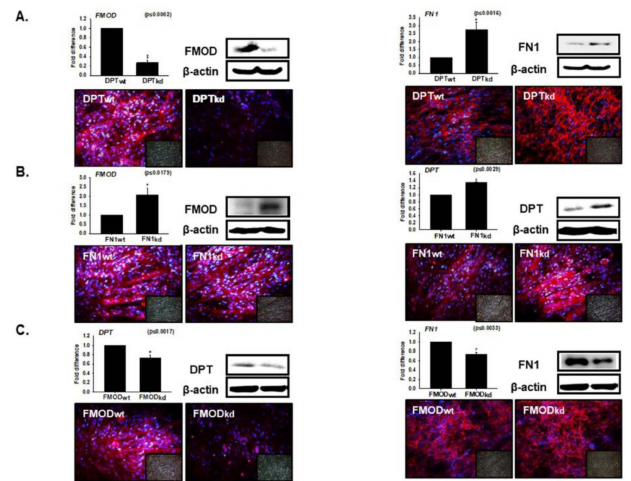
Figure 4. Relationship of DPT with fibromodulin (FMOD) and FN during myoblast di ff erentiation. Knockdown cells of FMOD, DPT, and FN were incubated with 2% FBS for 4 days. ( A ) FMOD and FN mRNA expression were evaluated by real-time RT-PCR, and protein expression by Western blot and immunocytochemistry in DPT kd cells. ( B ) FMOD and DPT mRNA expression was assessed by real-time RT-PCR, and protein expression by Western blot and immunocytochemistry in FN kd cells. ( C ) DPT and FN mRNA expression were assessed by real-time RT-PCR, and protein expression by Western blot and immunocytochemistry in FMOD kd cells. DPT wt , FMOD wt , and FN wt indicate cells transfected with the scrambled vector. * p ≤ 0.05, ** p ≤ 0.001, *** p ≤ 0.0001.